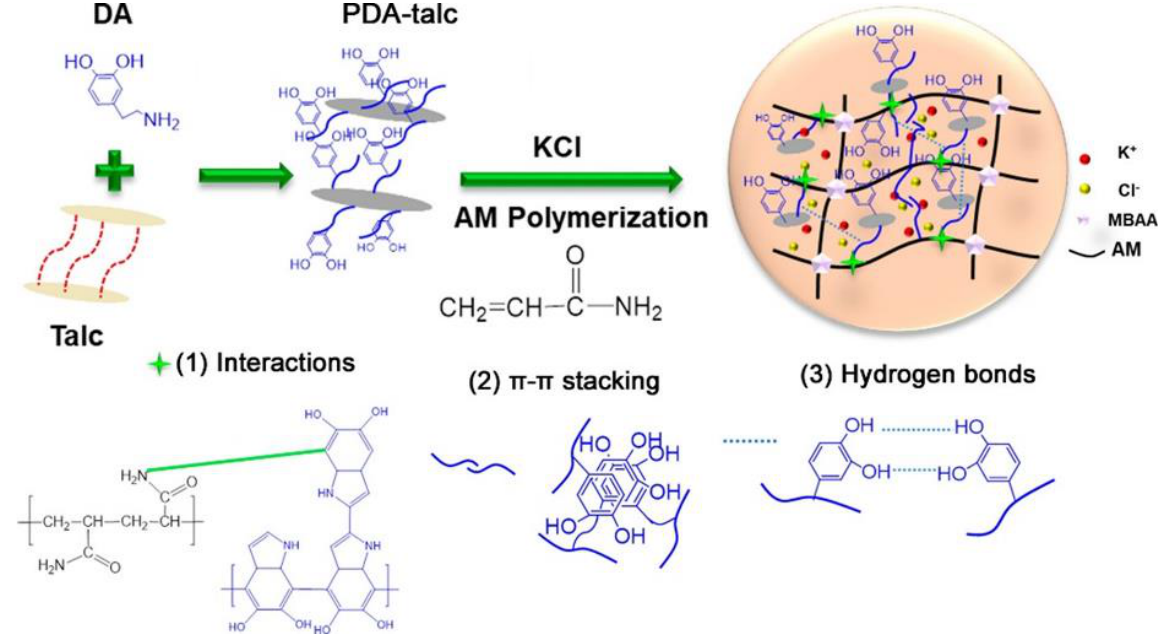
Figure 18. Schematic of the fabrication process of the DA-talc-PAM hydrogel [88].